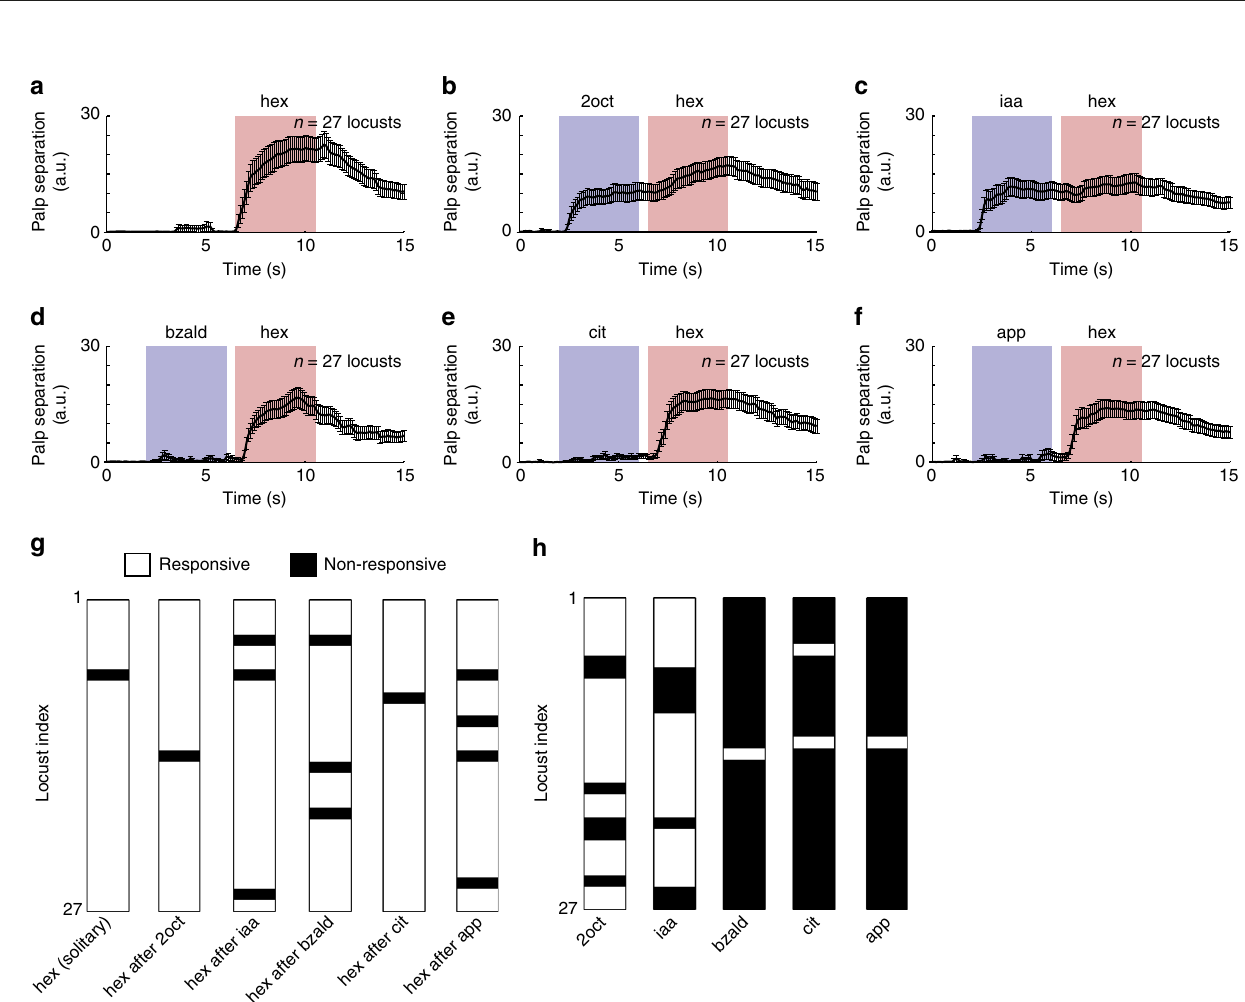
Fig. 5 Robust behavioral response to a conditioned stimulus. a Locusts were trained to associate an odorant with a food reward. Trained locusts subsequently responded to the conditioned stimulus presentations by opening their sensory appendages close to their mouths called maxillary palps. The distance between the palps was tracked and plotted as a function of time. Mean palp-opening response of locusts trained to recognize hexanol (conditioned stimulus) is shown. Error bar represents standard error across locusts ( n = 27). b – f Palp-opening responses to fi ve different sequential presentations of hexanol (i.e. the conditioned stimulus) are shown. Note that these stimulus sequences are identical to the ones used in our physiology experiments. g PORs of each locust to hexanol were classi fi ed as responsive and non-responsive and shown for solitarily and each sequential presentation of the conditioned stimulus. h PORs of each locust to the fi ve distractor odorants: 2oct, iaa, bzald, cit, and app are shown